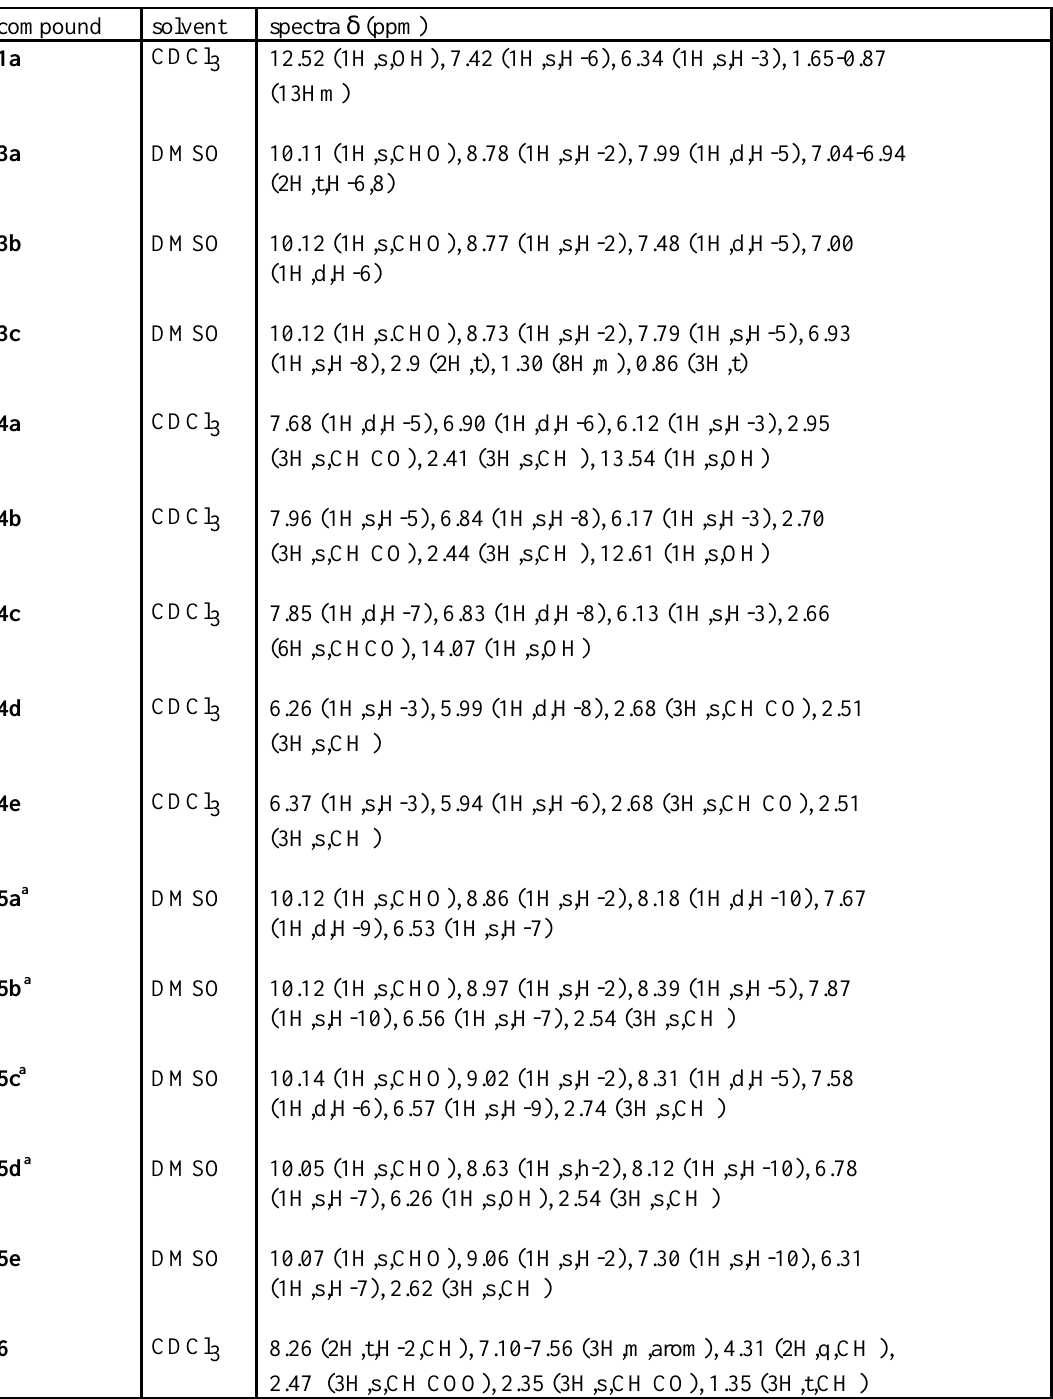
Table 3. 1H NMR - spectral